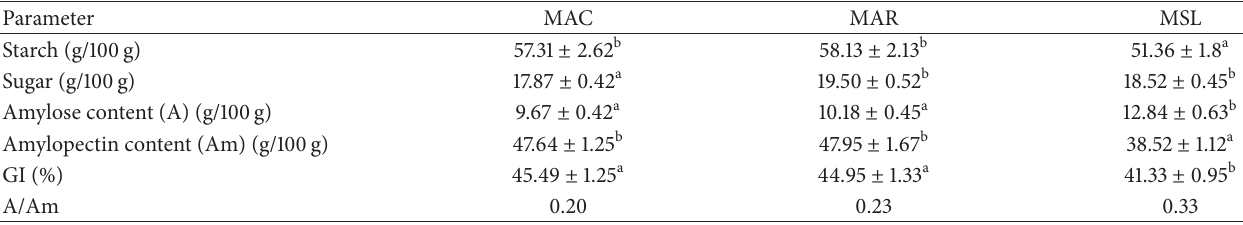
Table 1: The starch, sugar, amylose and amylopectin contents, amylose/amylopectin ratio, and glycemic index (%) of Musa sapientum (Latundan banana) (MSL), Musa acuminata (Cavendish banana) (MAC), and Musa acuminate (Red Dacca) (MAR).